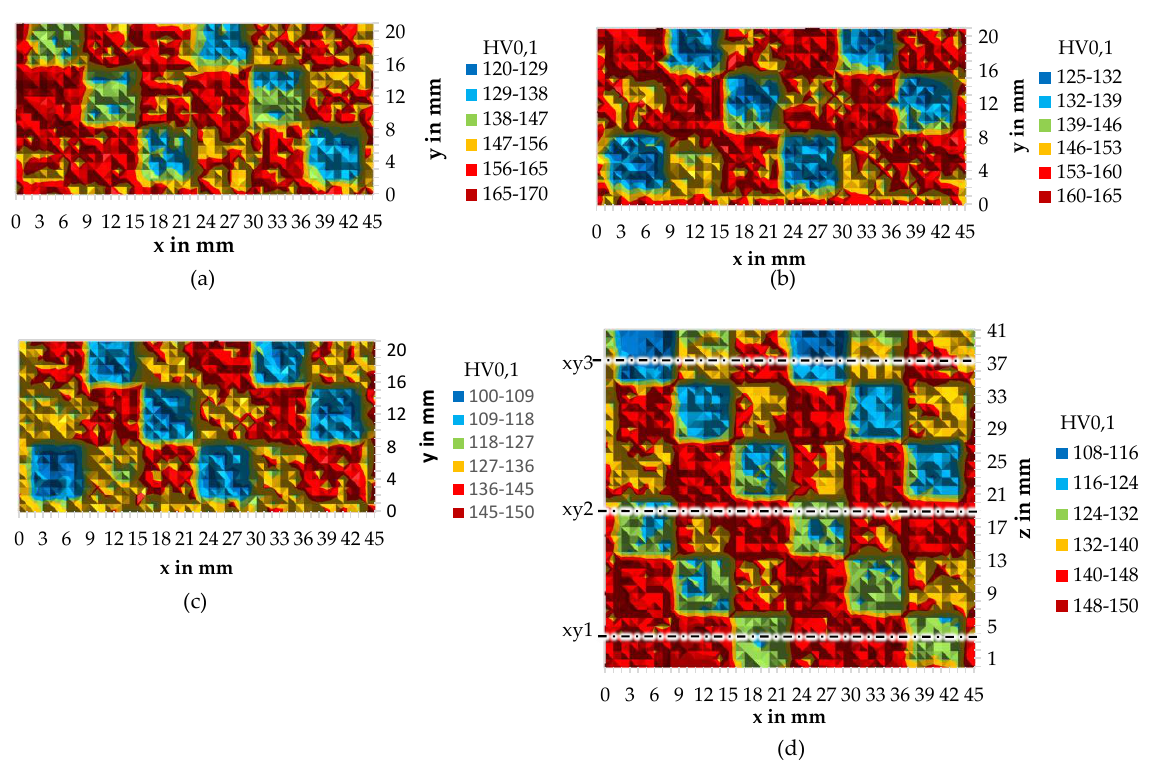
Figure 9. Microhardness HV 0.1 in different cross sections: ( a ) xy1, ( b ) xy2, ( c ) xy3, and ( d ) xz.